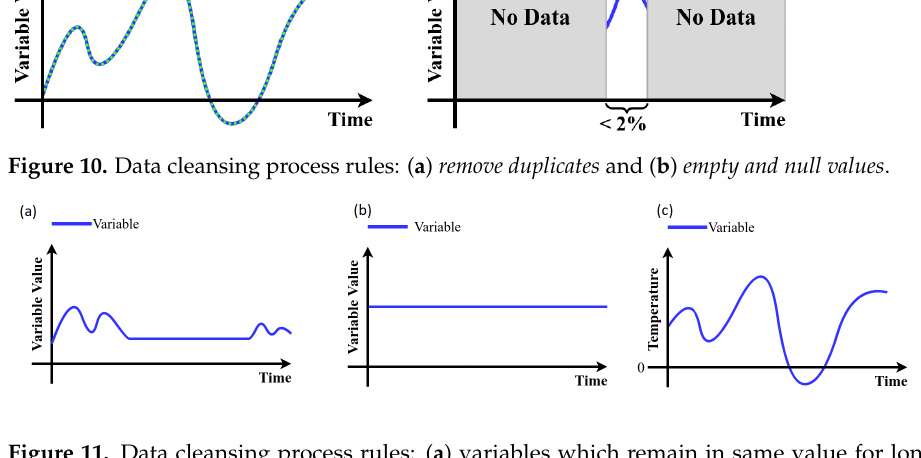
Figure 11. Data cleansing process rules: ( a ) variables which remain in same value for long time periods, ( b ) unique values, and ( c ) negative temperature cases.